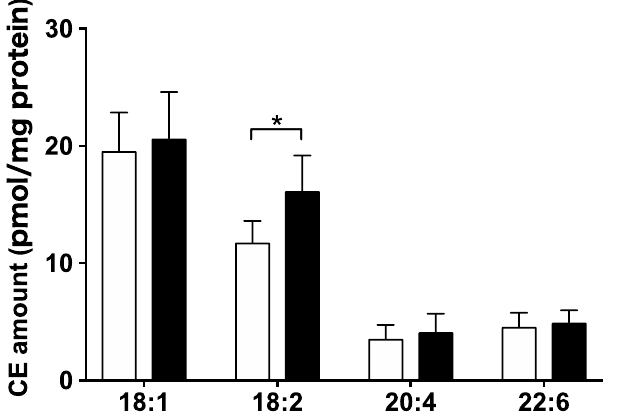
Figure 4. Comparison of CE species in lysoPE-supplemented (black bars) and unsupplemented (white bars) C3A cells detected using Orbitrap LC-MS/MS. Results are shown as mean ± standard deviation. n = 6. Student’s t -test, * p < 0.05.